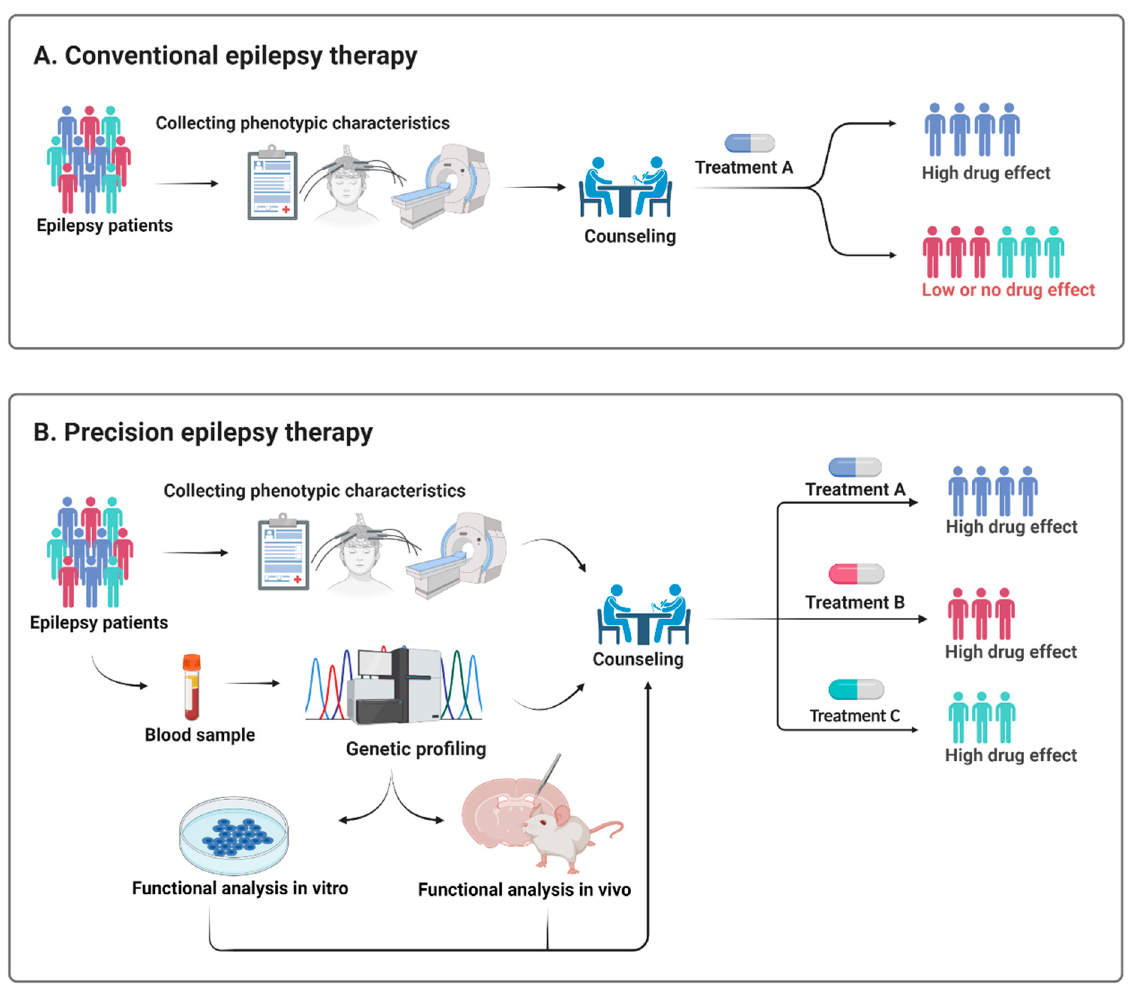
Figure 2. Schematic illustration of how a precision therapy could be applied in epilepsy. Treatment of epilepsy remains largely empirical and rather than the present trial and error approach ( A ), genetic testing and preclinical in vitro and in vivo models may enable healthcare providers to select a more targeted treatment approach ( B ).